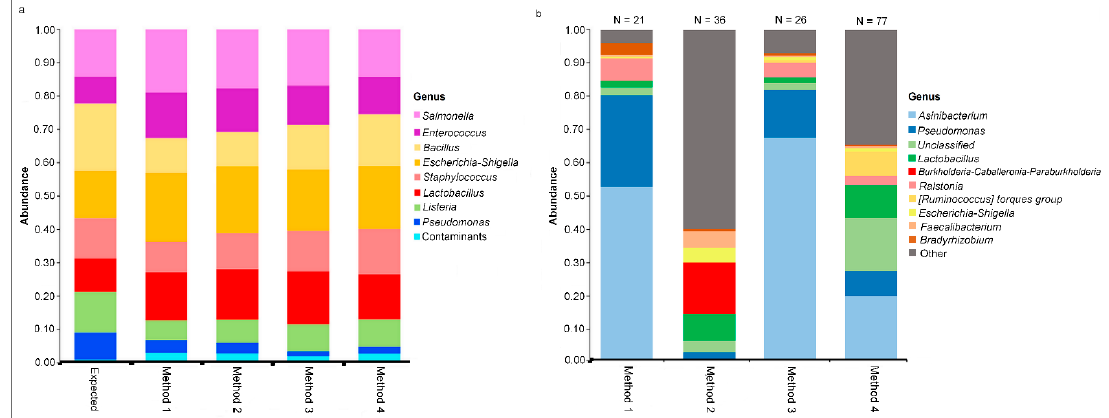
Figure 2. Distribution of genera detected in the mock community is similar across each DNA extraction method, but not among negative controls. Relative abundance of the genera detected in mock community ( a ) and negative controls ( b ) among each DNA extraction method. In the mock community, contaminants are considered any genera not among those specified by the expected standard. In the negative controls, the top 10 genera are shown in each method and the total relative abundance of additional genera are shown in the grey “Other” category. The number of total genera detected in each negative control is shown at the top of the bar chart.